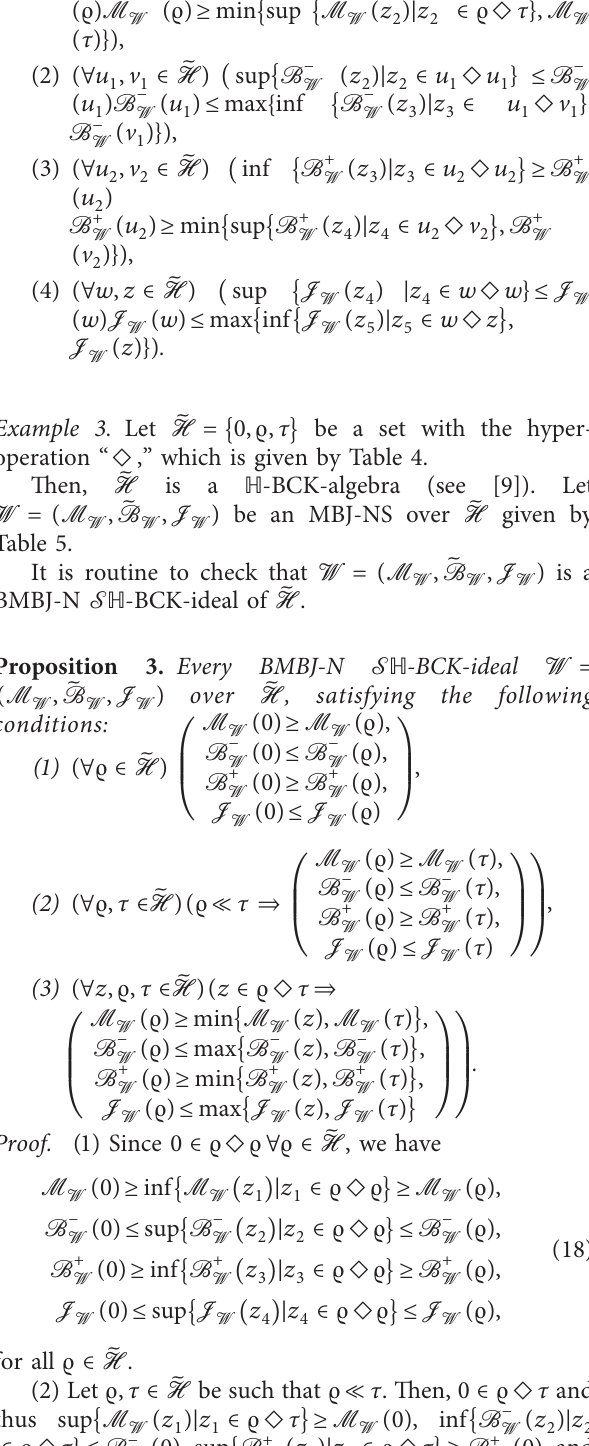
Table 3: Tabular representation of W � ( M